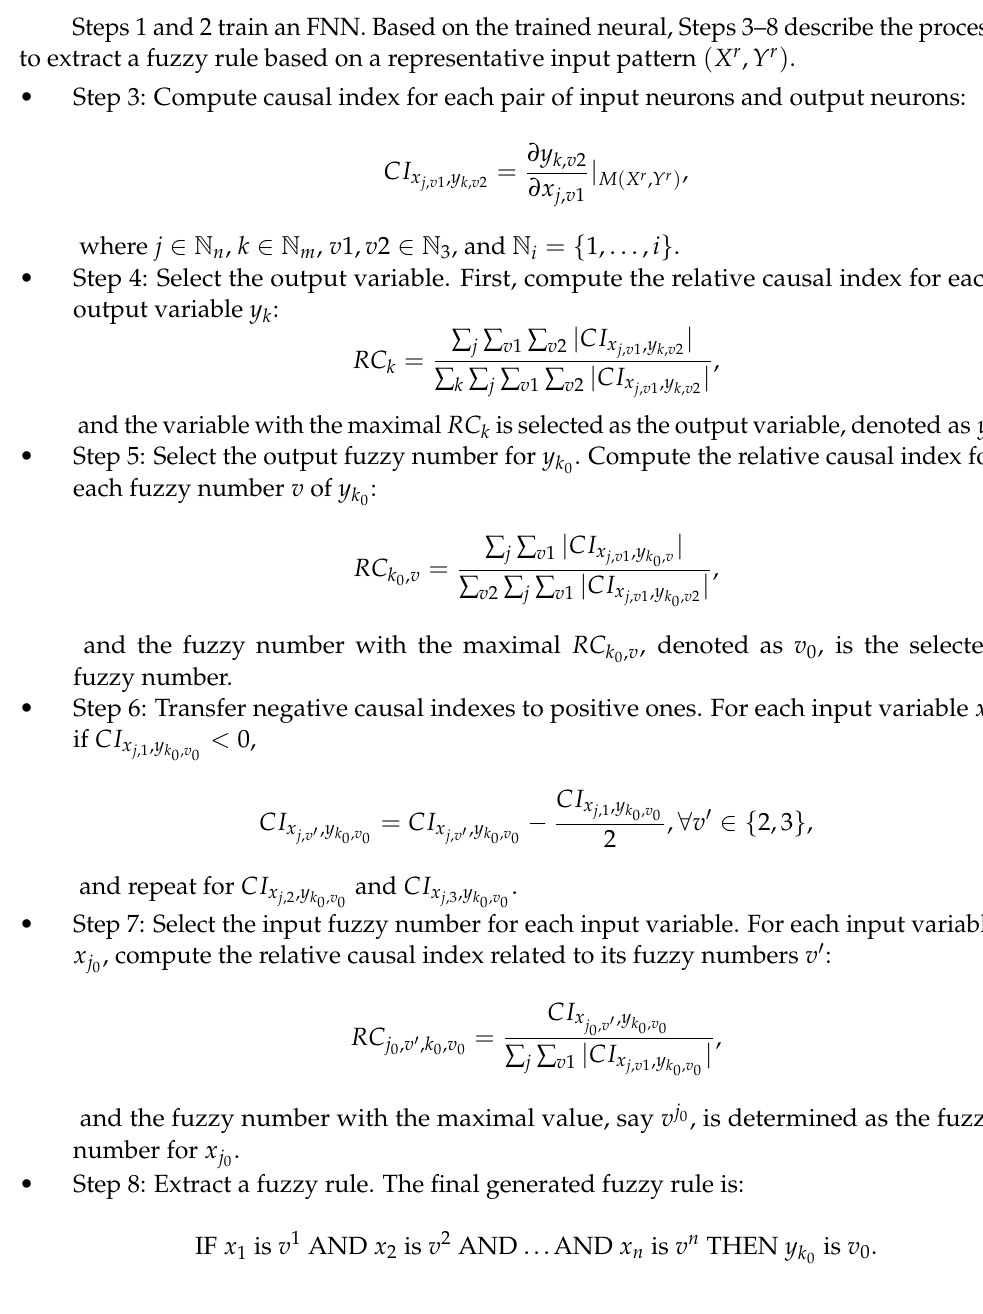
Figure 1. The architecture of FNN: A normal three-layer neural network that takes the membership values of the input and output variables’ fuzzy numbers as input and output